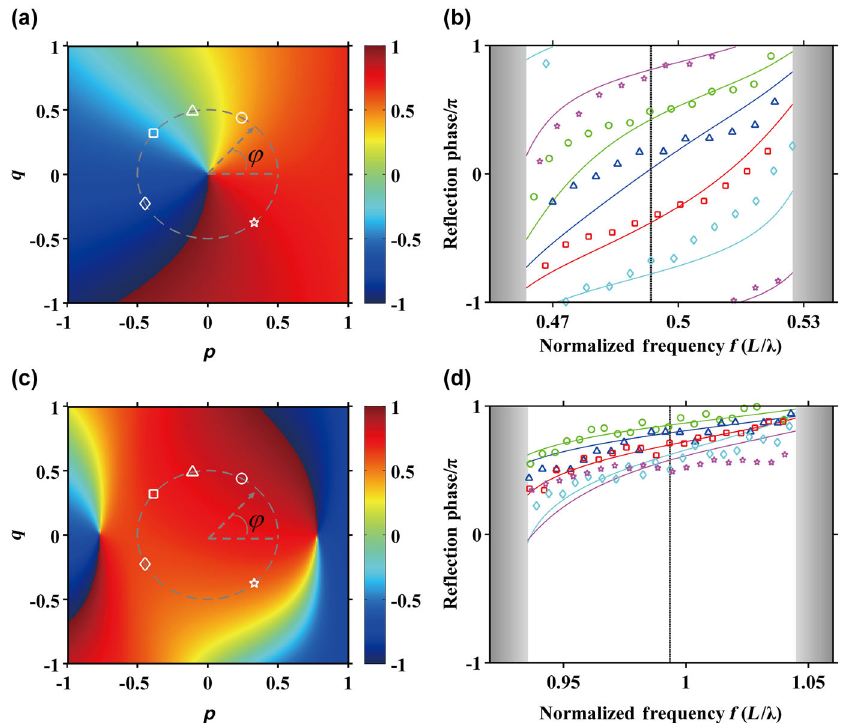
FIG. 3. The reflection phase in the p - q space. (a),(c) Reflection phase in the p - q space at the frequency of the Weyl point in Figs. 2(a) and 2(b). The reflection phase shows a vortex structure with charge − 1 around Weyl points. The white circle, triangle, square, diamond, and pentagram mark the values of ð p; q Þ of the five samples, which are, respectively, ð p; q Þ ¼ ð 0 . 24 ; 0 . 44 Þ , ð − 0 . 11 ; 0 . 49 Þ , ð − 0 . 38 ; 0 . 31 Þ , ð − 0 . 45 ; 0 . 22 Þ ,and ð 0 . 33 ; − 0 . 37 Þ . These five samples have configurations located on a circle (dashed gray line) in the parameter space which encloses a Weyl point in (a) but does not enclose any Weyl point in (c). (b),(d) Reflection phases in the band gaps of the five samples in (a) and (c). The markers show the experimental results whose shape marks the position in the p - q space in (a) and (c), and colored lines represent the corresponding reflection phases from numerical simulations. The black dashed lines mark the frequencies of the Weyl points in (a) and (c), and the bulk band regions of the PC with the narrowest band gap are shaded in